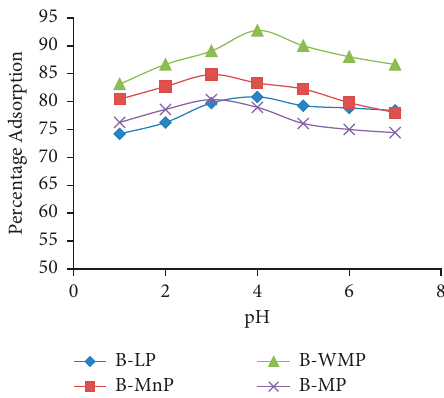
Figure 6: Effect of pH on the sorption of Cr (VI) on different sorbents.